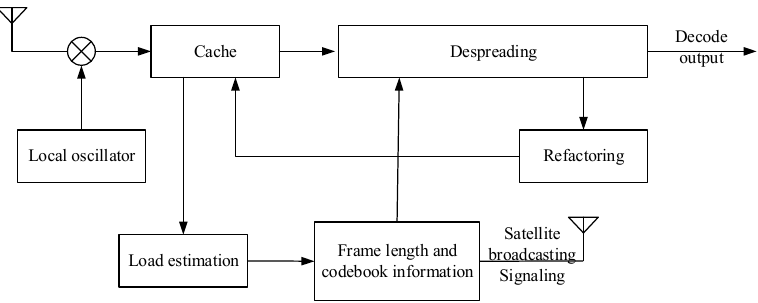
Figure 7. User ‐ side architecture design.